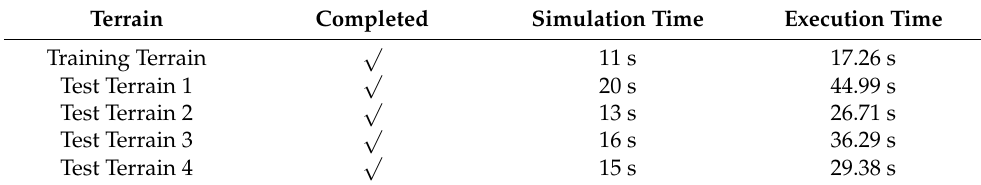
Table A1. Execution time for the evaluation